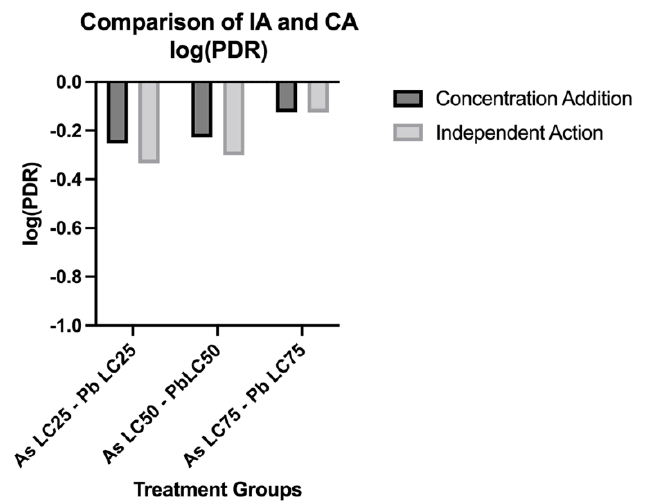
Figure 5. Comparison of predicted lethality using the Independent Action (IA) and Concentration Addition (CA) models. The log of the prediction deviation ratios (PDR) of mixtures for the CA and IA models. N = 3 biological replicates for each treatment group with 50 subsamples per each treatment group.